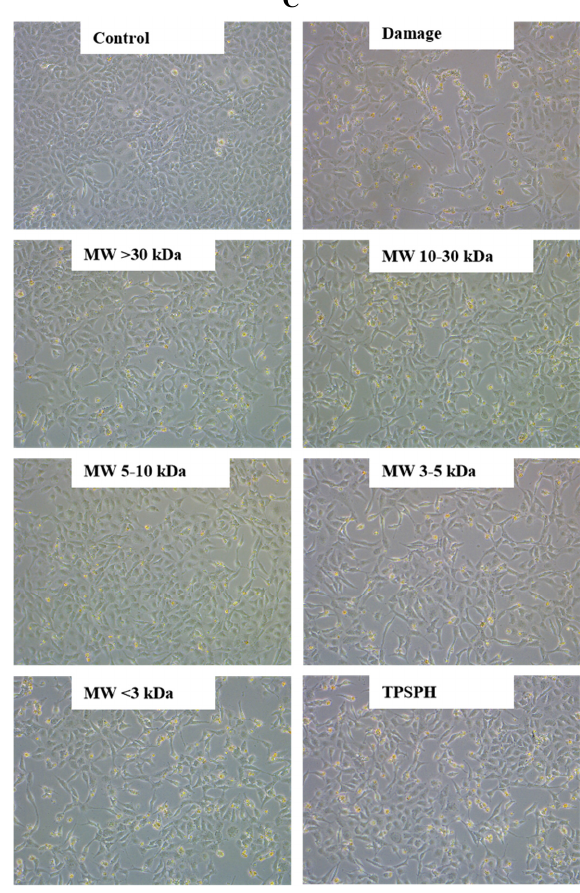
Figure 6. The cytoprotective effects of TPSPH and five fractions on HepG2 cells. ( A ) Cytotoxic effect. ( B ) Protective effects on H 2 O 2 -induced oxidative damage in HepG2 cells. # p < 0.05 versus the control group, different letters indicate significant differences between sample groups and the damage groups. ( C ) The morphology of HepG2 cells pre-incubated with TPSPH and its five frac- tions were observed by microscopy.